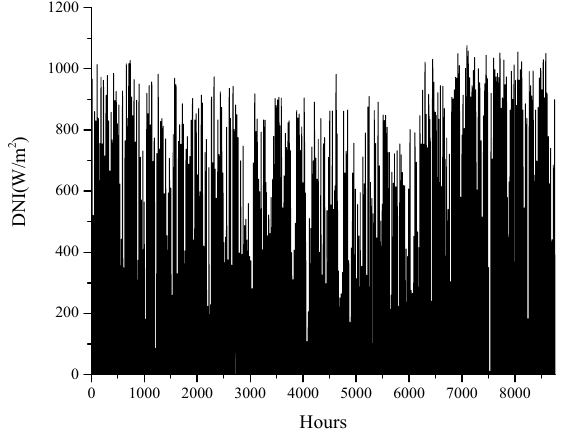
Figure 3. Yearly Direct Normal Irradiance (DNI) distribution of Lhasa. Table 2. Recommended average days of month.